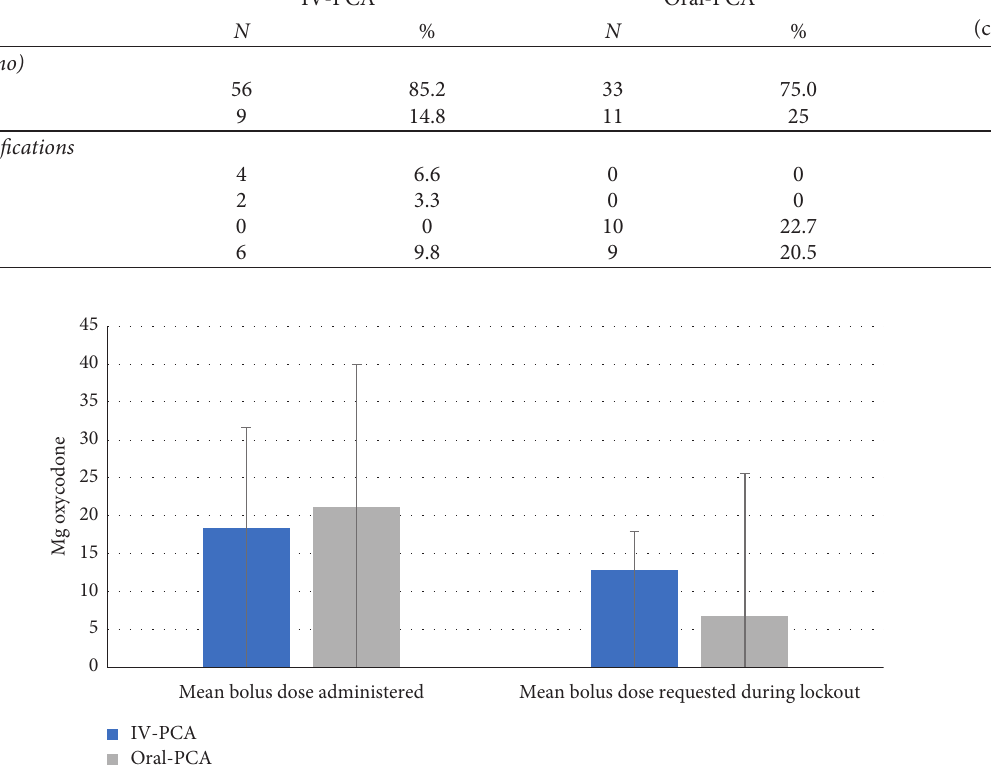
Figure 3: Comparison of mean total bolus dose administered and requested during lockout intervals, during the PCA treatment, in both cohorts, by means of T -test for independent